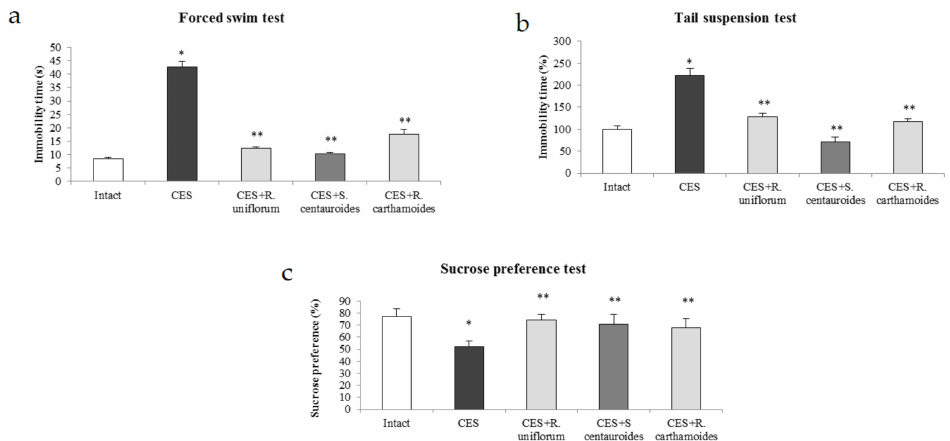
Figure 2. Antidepressive effects of R. uniflorum and S. centauroides extracts in the forced swim ( a ), tail suspension ( b ) and sucrose preference tests ( c ) in the model of chronic emotional stress (CES). Data represent as mean ± S.E.M. *— p < 0.05 vs. intact group; **— p < 0.05 vs. CES